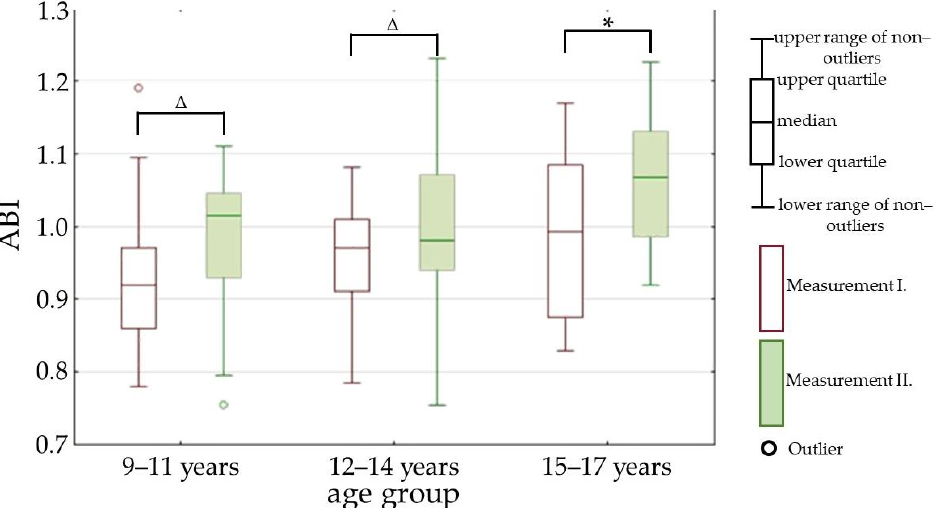
Figure 5. Ankle-brachial index (ABI) in measurements I. and II. Measurement I.—at the beginning of the one-month stay in the children’s hospital; measurement II.—at the end of the one-month stay in the children’s hospital; *— p value is less than 0.01; ∆ — p value is less than 0.05; p value— statistical evaluation of the differences between the measurements I. and II., Wilcoxon signed-rank test (paired